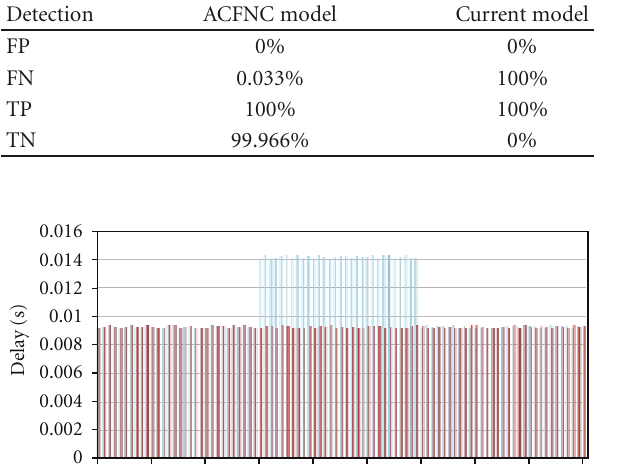
Table 4: Detection accuracy of the ACFNC model. Detection